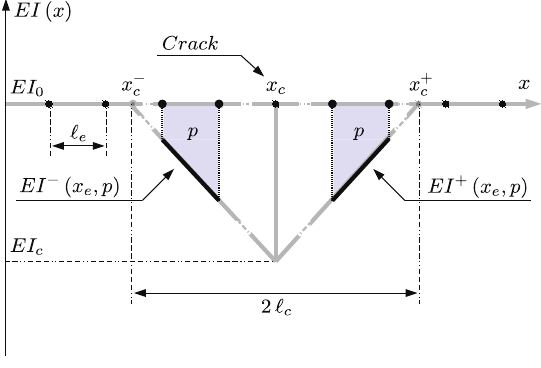
Fig. 1. Triangular stiffness reduction extended on several